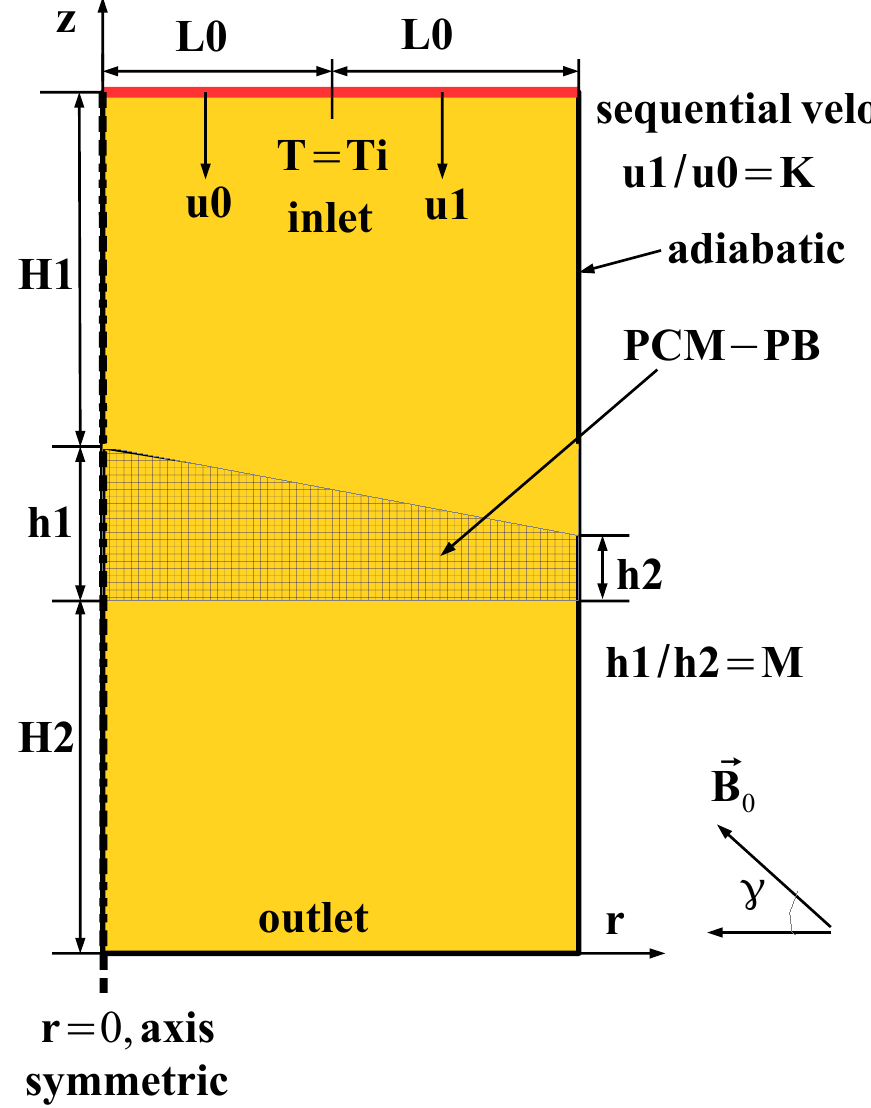
Figure 1. Schematic view of the geometry with boundary